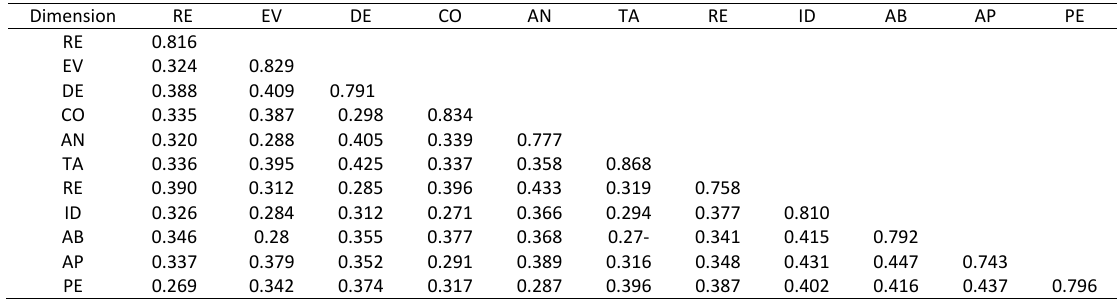
Table 5: Diagnostic validity of the dimensions of the research model Dimension